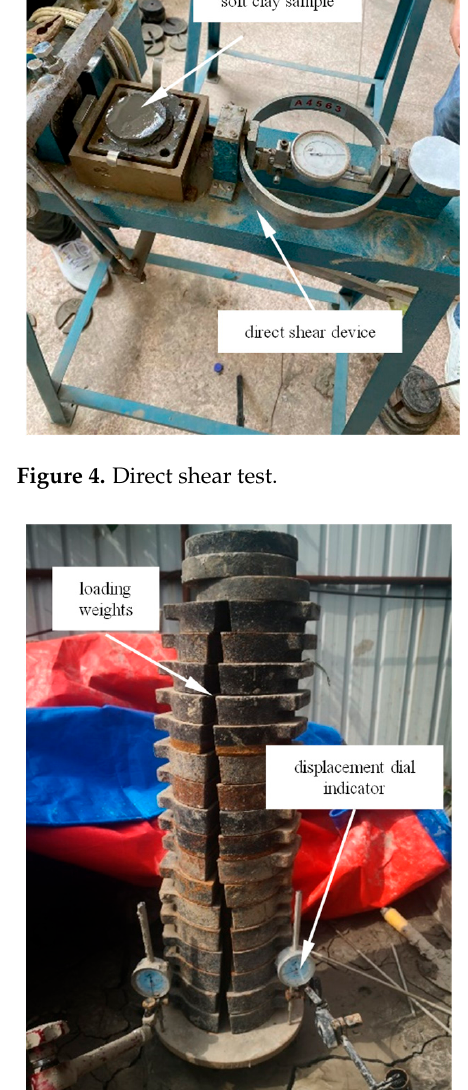
Figure 5. Static load test.